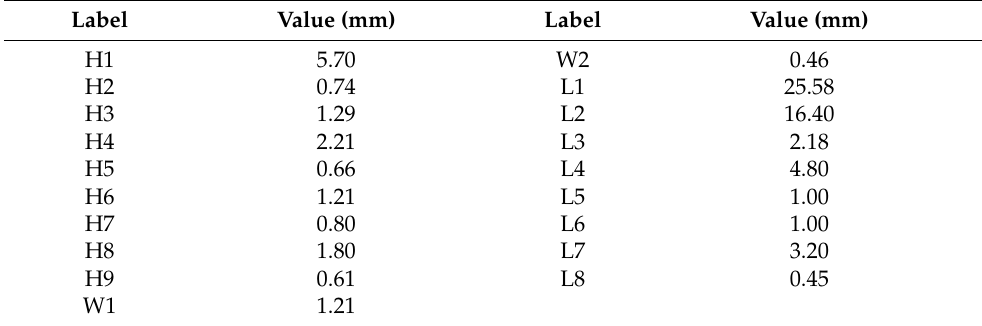
Table 1. Inverted F PCB printed antenna dimensions.